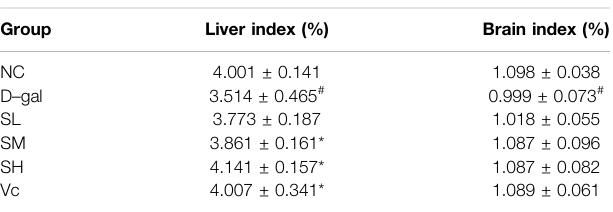
TABLE 5 | Mice organ